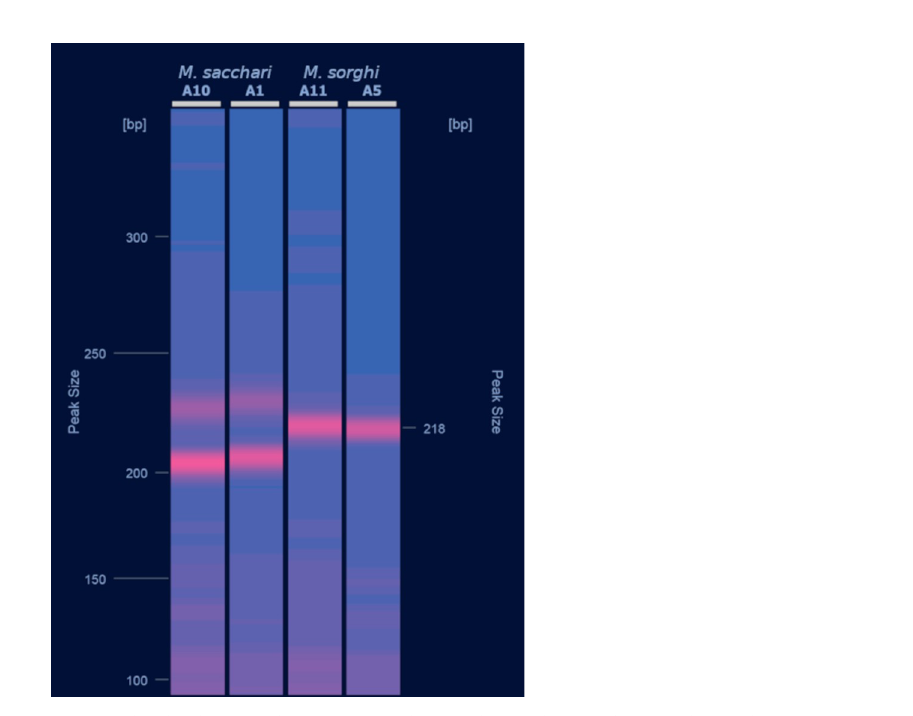
Fig 8. Molecular diagnosis for separation of M . sacchari and M . sorghi using the SSR locus CIR-Ms-G01. M . sacchari (MLL-D) are in lanes A10 (voucher # SNIB00040_0101) and A1 (voucher # SNIB00233_0102). M . sorghi (MLL-F) are in lanes A11 (voucher # SNIB00075_0101) and A5 (voucher # SNIB000237_0102). The PCR was carried out according to [14]. The migration of PCR products was carried out on a Qiagen Qiaxcel electrophoresis analyzer. The image was generated by the Qiaxcel ScreenGel 1.6.0 software (see original image in S1 Raw image).